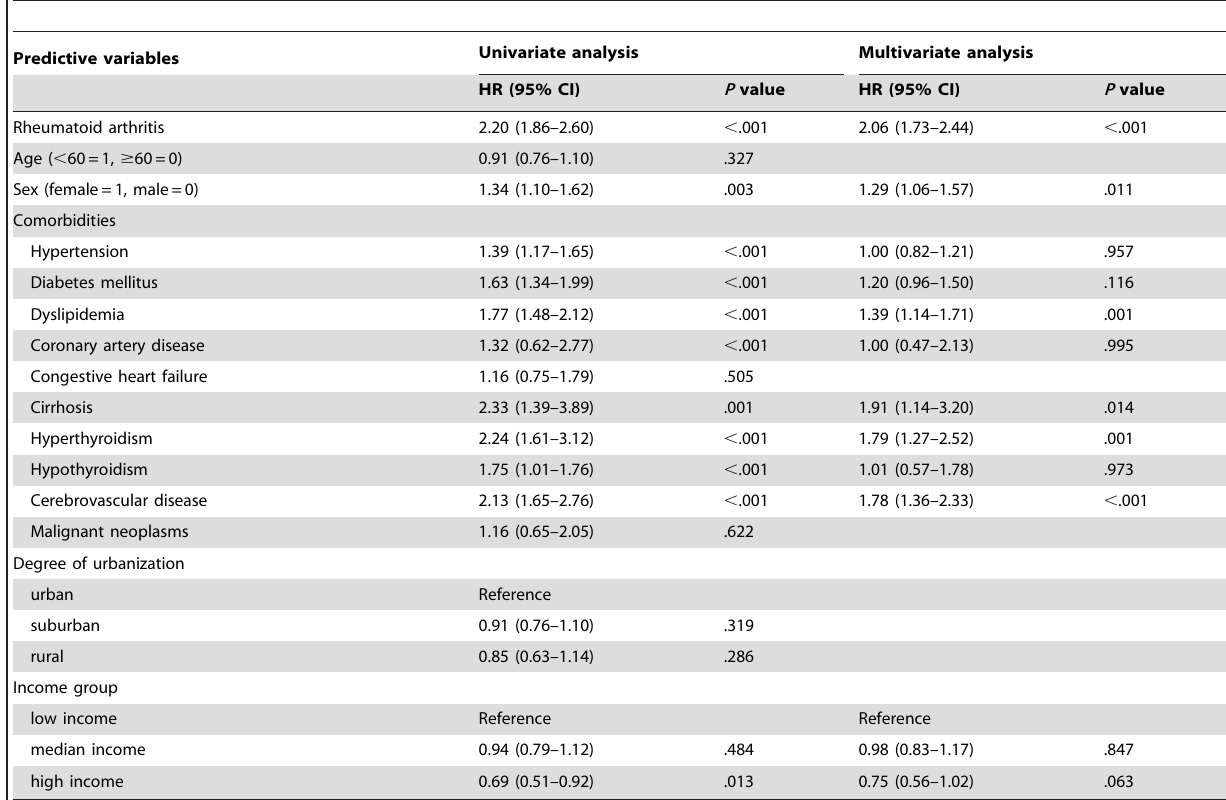
Table 3. Analyses of Risk Factors for Depressive Disorders in Patients with and without Rheumatoid